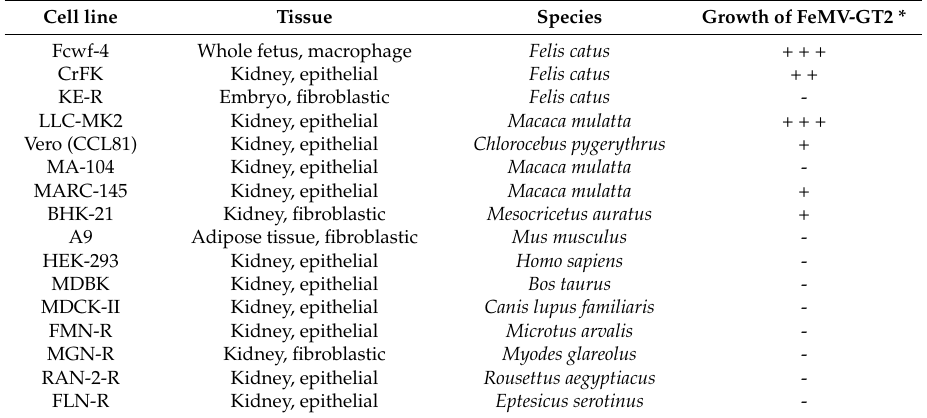
Table 2. Growth spectrum of FeMV-GT2-Gordon strain in different cell